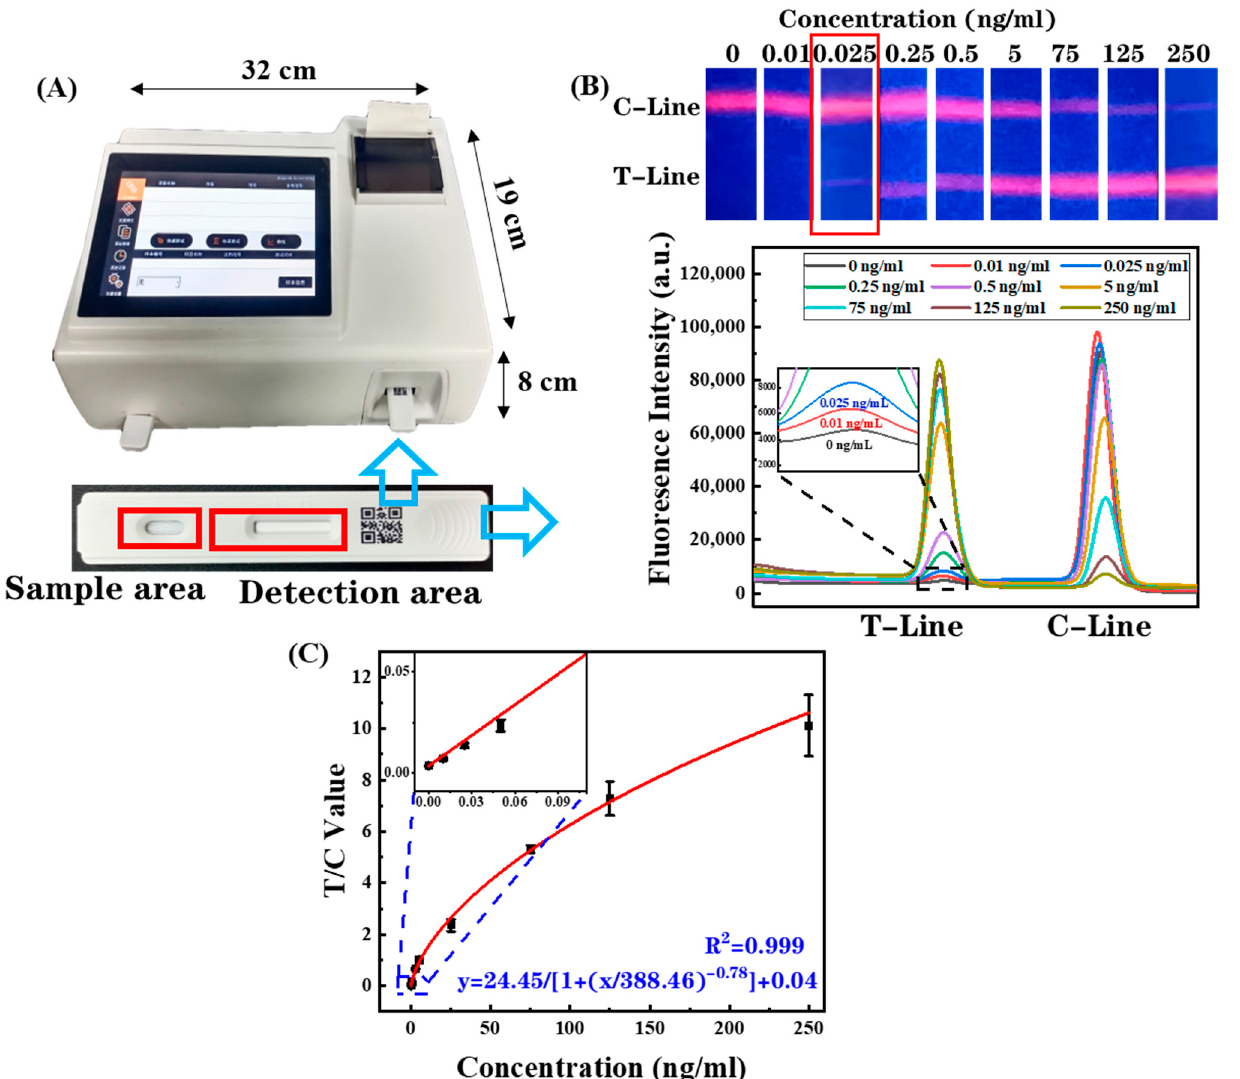
Figure 6. ( A ) Real products of the benchtop fluorescence analyzer. ( B ) The detection results read by the benchtop fluorescence analyzer compared with fluorescence photos. ( C ) The standard curve of CRP detection analyzed by the benchtop fluorescence analyzer.